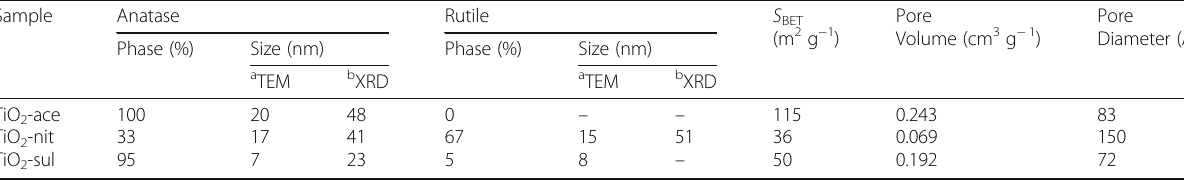
Table 1 Results From XRD, TEM, and N 2 -physisorption Measurements